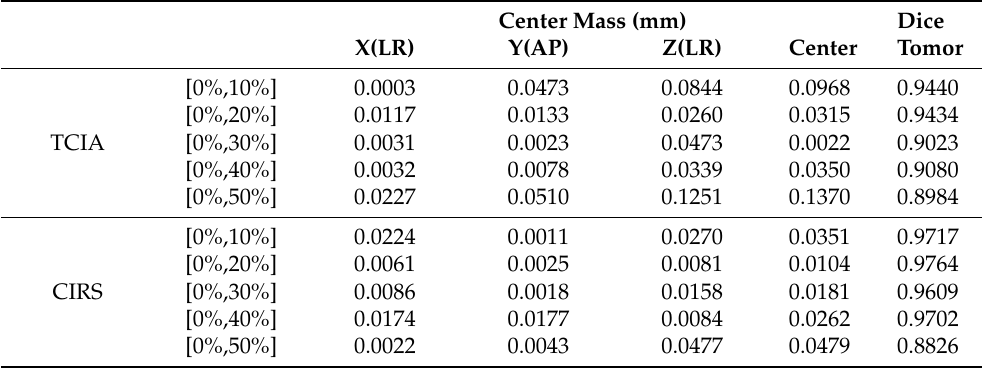
Figure 5. Tumor registration results from the exhalation end to other stages. Where ( a ) is the 3D presentation of the results before and after a real patient’s lung and tumor registration, and ( b ) is of the phantom data of the 3D results of the tumor display. The odd rows are the unregistered images, and the even rows are the post-registered images. The red image indicates the ground truth. Blue is the moving image, and green is the predicted result obtained by the model. Table 2. The accuracy of tumor location from the expiratory end to each